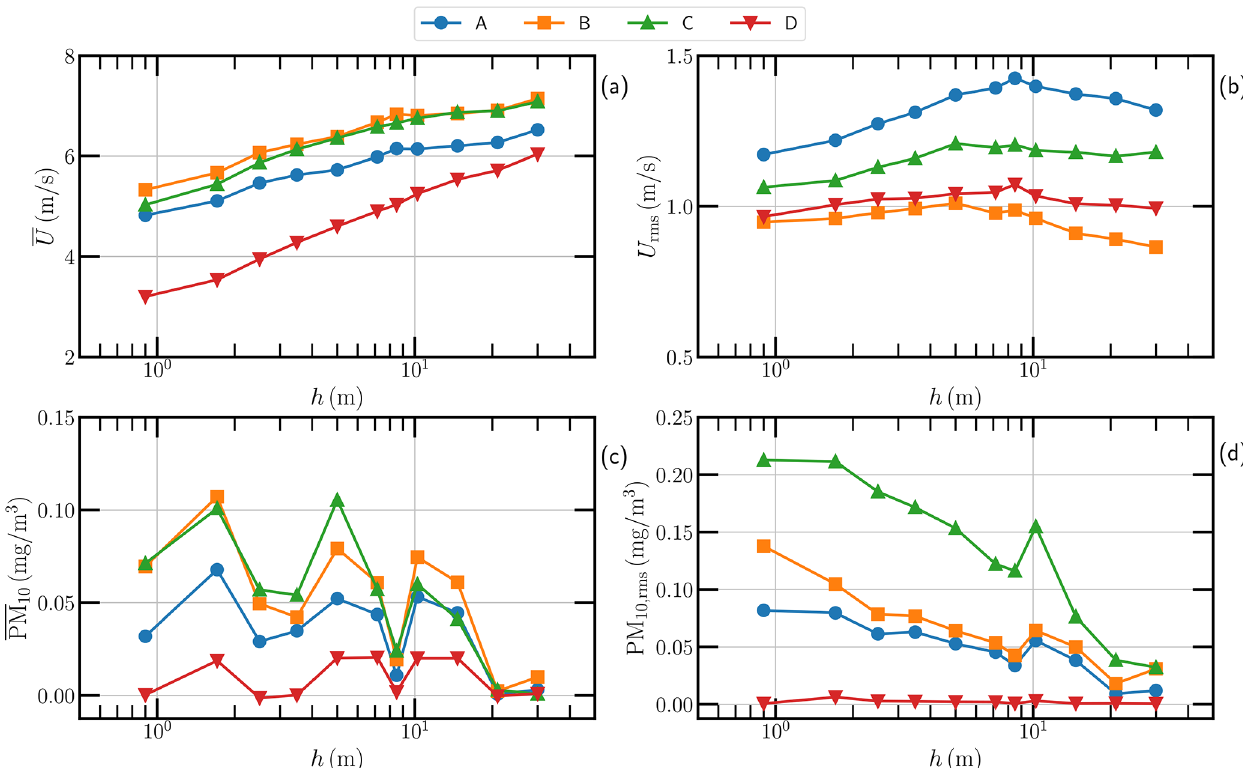
Figure 6. (a) Hourly averaged wind speed U versus height h at the same four periods as in Fig. 5. (b) The corresponding root-mean-square speed. (c) Hourly averaged concentration PM 10 and (d) the corresponding root-mean-square